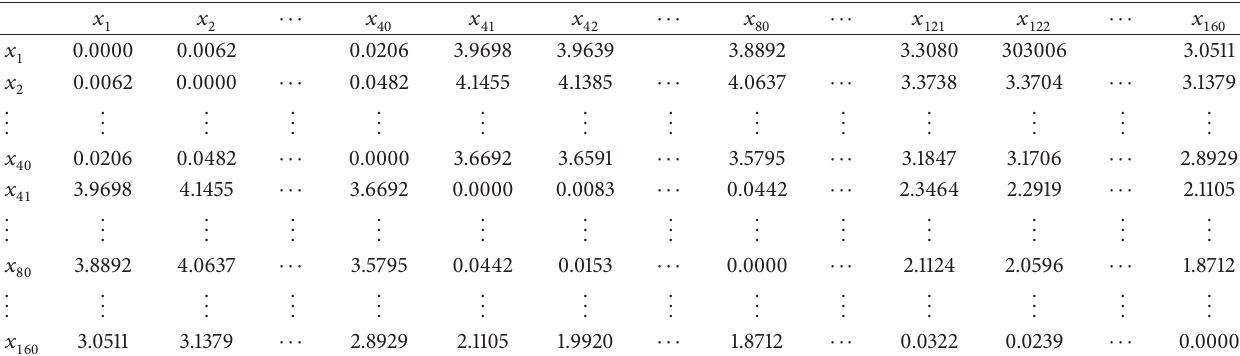
Table 3: Distances between each point of rolling bear dataset1.